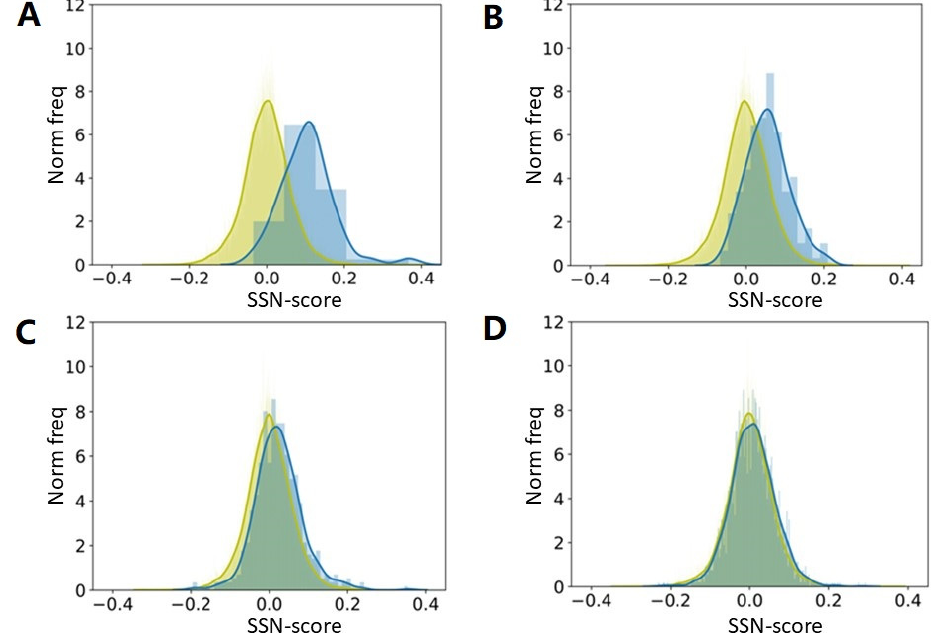
Figure 4. Secondary structure normality (SSN) scores for all 22,405 proteins when preference parameters are based on a small, randomly selected subset of all proteins. From ( A – D ) the preference parameters are determined from 50, 150, 500, and 2000 proteins, respectively (in blue). SSN scores for the proteins in the small training sets are in blue and for the complete set of 22,405 proteins in yellow. Both training and test set are shown as a normalized histogram with the width of the bins chosen to have the maximum count between 6 and 10, and similar between the two distributions. The curves are obtained from those histograms using a kernel density estimation. The abscissa is based on the SSN scores for the proteins in the training